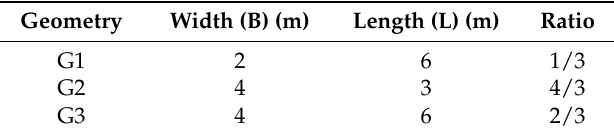
Table 1. The geometry of the reservoirs.